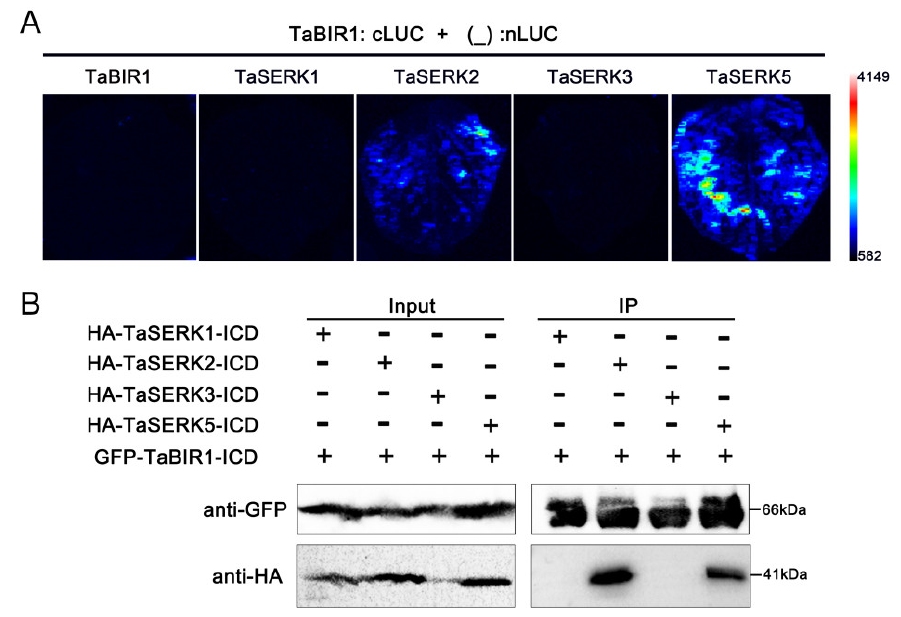
Figure 7. TaBIR1 associates with TaSERK2 and TaSERK5. ( A ) Interaction between TaBIR1 and TaSERK2, TaSERK5 confirmed by split-luciferase assay. TaBIR1 :cLUC and indicated proteins with C-terminal nLUC were coexpressed in N. benthamiana by agroinfiltration. Images of chemiluminescence were recorded by applying 0.5 mM luciferin at 48 h after infiltration. ( B ) Interaction between TaBIR1 and TaSERK2, TaSERK5 verified by Co-IP assay. Intracellular domains (ICD) of TaSERKs were individually co-expressed with GFP tagged TaBIR1 in N. benthamiana. Total proteins were extracted and immunoprecipitated by anti-GFP Agarose beads. The total proteins and immunoprecipitated proteins were detected using anti-GFP and anti-HA antibody.